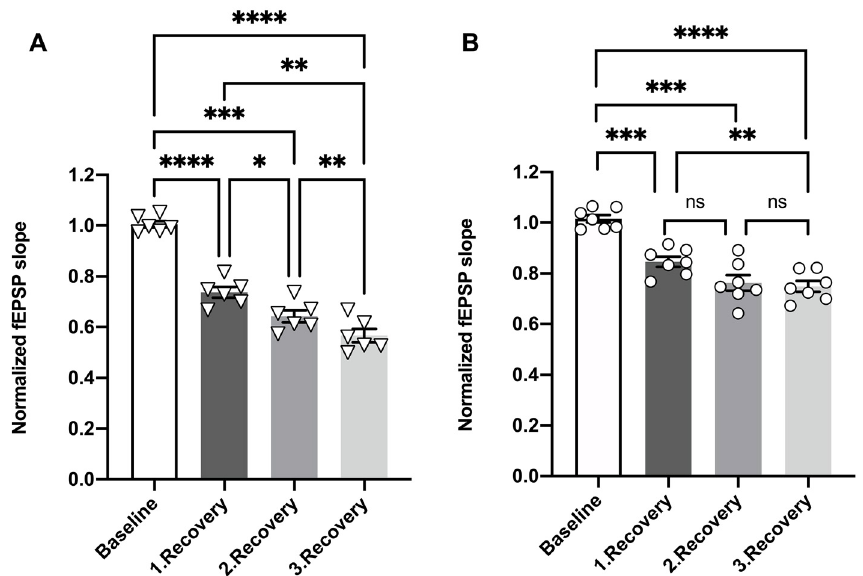
Figure 3. Repeated oxygen glucose deprivation (OGD) resulted in a steady impairment of synaptic transmission recovery in miRNA 132/212 − / − but not WT dentate gyri. Scatter plots depicting normalized fEPSP slope values at the normoxic, euglycemic baseline and the ends of the three recovery periods. ( A ) As revealed by within-subject analysis, fEPSP slopes recorded in slices obtained from miRNA 132/212 − / − mice (white filled inverted triangles) recovered to statistically significant lower values after OGD in comparison to each preceding recovery interval. ( B ) In contrast, in slices obtained from WT mice (white filled circles) within-subject analysis revealed statistically significant differences between fEPSP slope values reached at the first vs. the third recovery period, while values at the first vs. second and second vs. third recovery periods no longer differed significantly. Data is presented as mean ± SEM. fEPSP: field excitatory postsynaptic potential, OGD: Oxygen Glucose Deprivation. p < 0.05 was considered significant. * p < 0.05, ** p < 0.01, *** p < 0.001, **** p < 0.0001. ns: no statistical